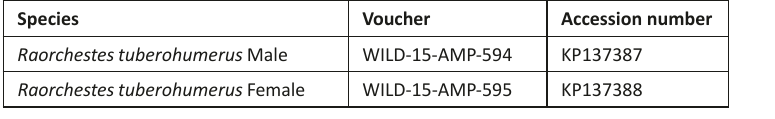
Table 1. Voucher and GenBank accession numbers for sequences used in molecular analysis.